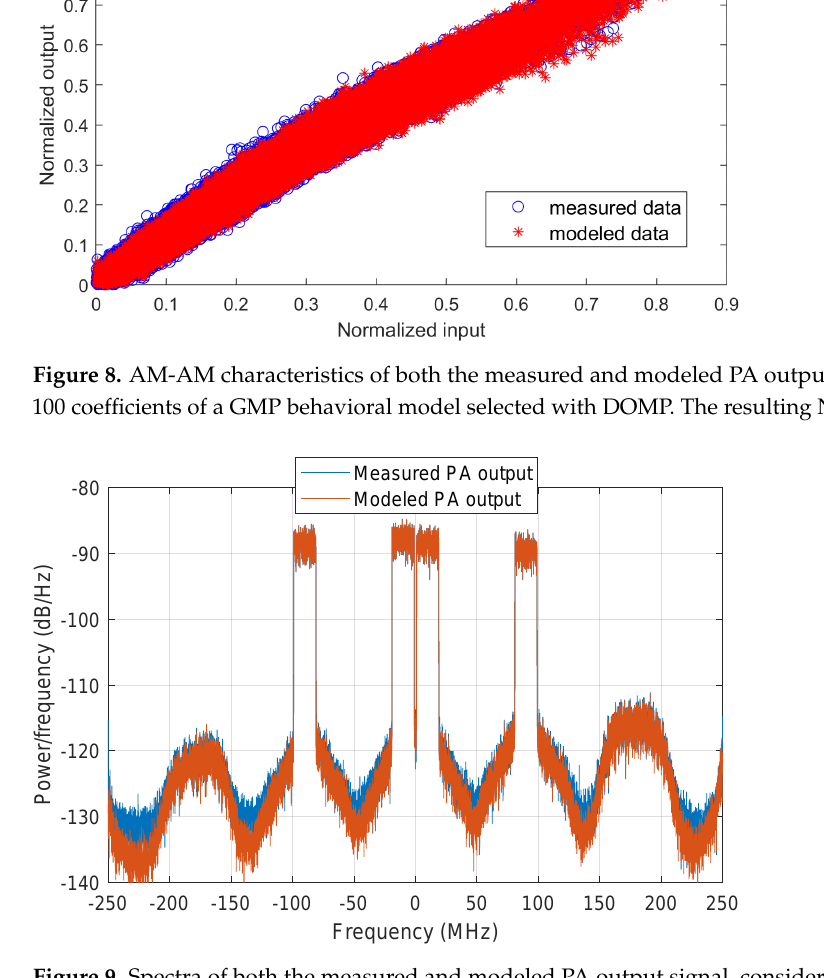
Figure 9. Spectra of both the measured and modeled PA output signal, considering 100 coefficients of a GMP behavioral model selected with DOMP. The resulting ACEPR is − 37.5 dB.